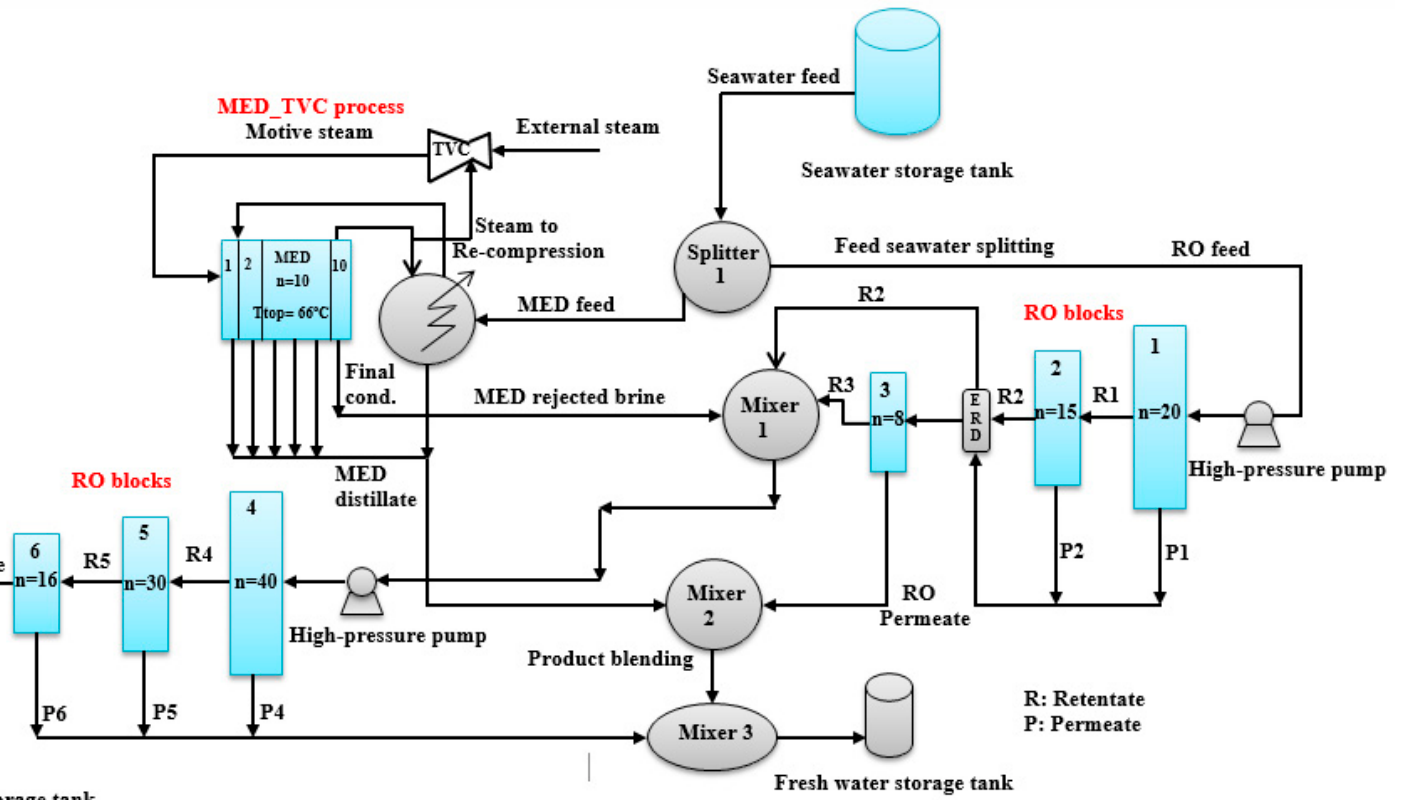
Figure 3. Schematic diagram of an integrated system of multi effect distillation and thermal vapour compression and double permeate reprocessing and retentate reprocessing reverse osmosis processes.